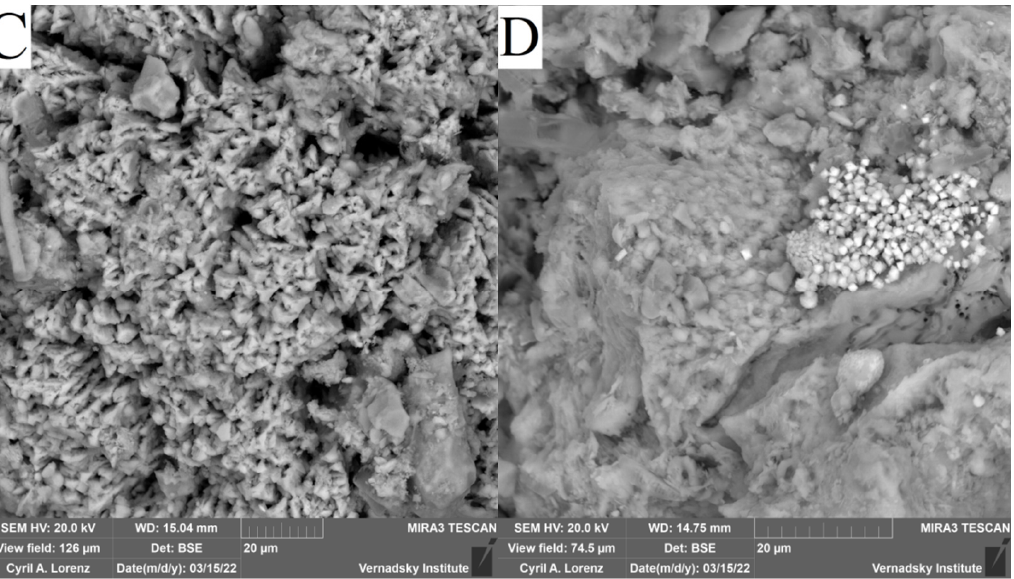
Figure 10. Verification results of thermodynamic calculations obtained by electron scanning microscopy with elemental analysis of the systems: ( A ) SO 4 ; ( B ) Ammophos; ( C ) Ammophos + SO 4 ; ( D ) Ammophos + SO 4 .